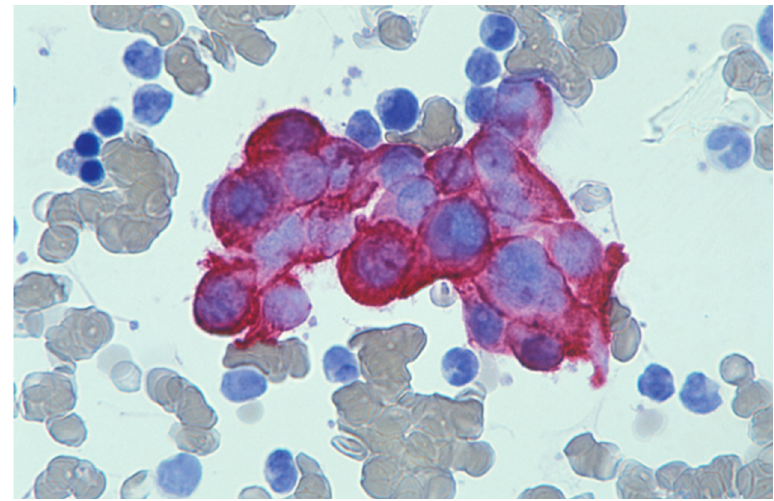
Figure 4. Bone marrow aspirate stained with a cytokeratin antibody (LP34) showing metastatic breast cancer cells (bone marrow aspirate; haematoxylin counterstain. ×1000).